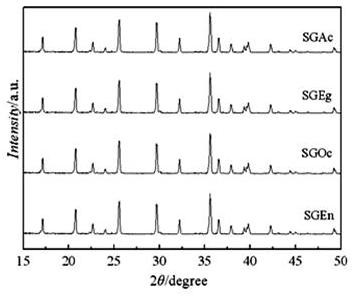
XRD patterns of LiFePO4/C synthesized by sol-gel method with different complexing agents.